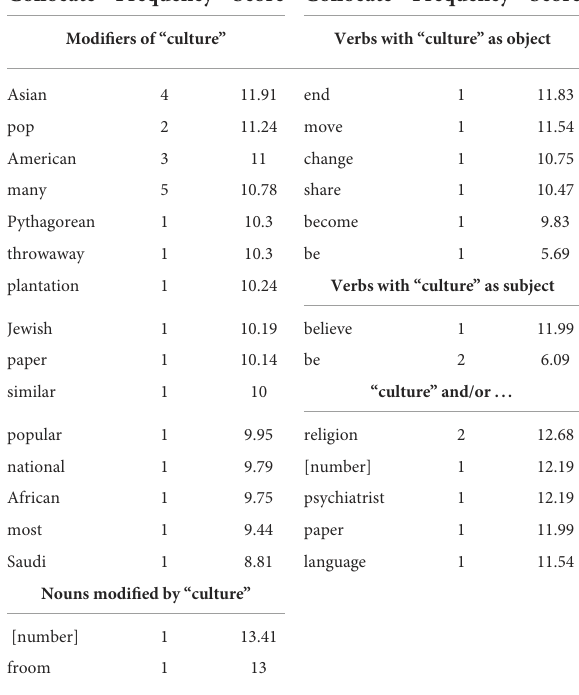
TABLE 4 Collocates of “culture” in the English